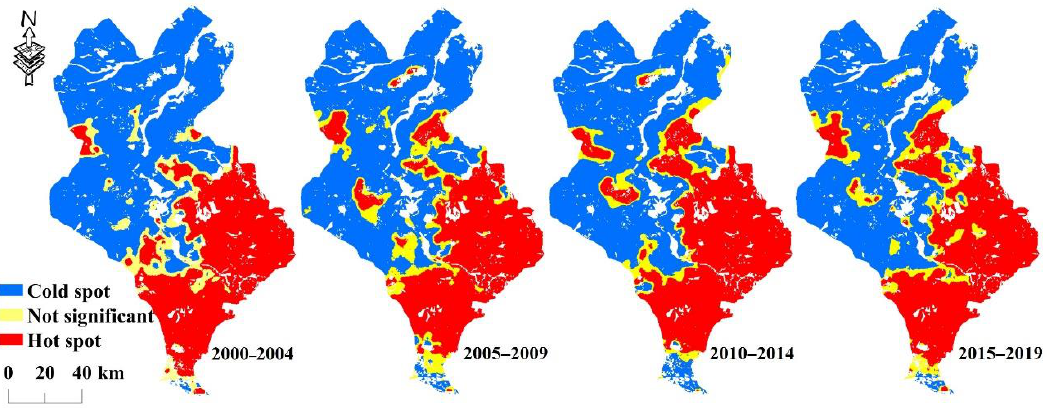
Figure 13. The cold and hot spots distribution of four ecosystem services in the study area, from 2000 to 2019.